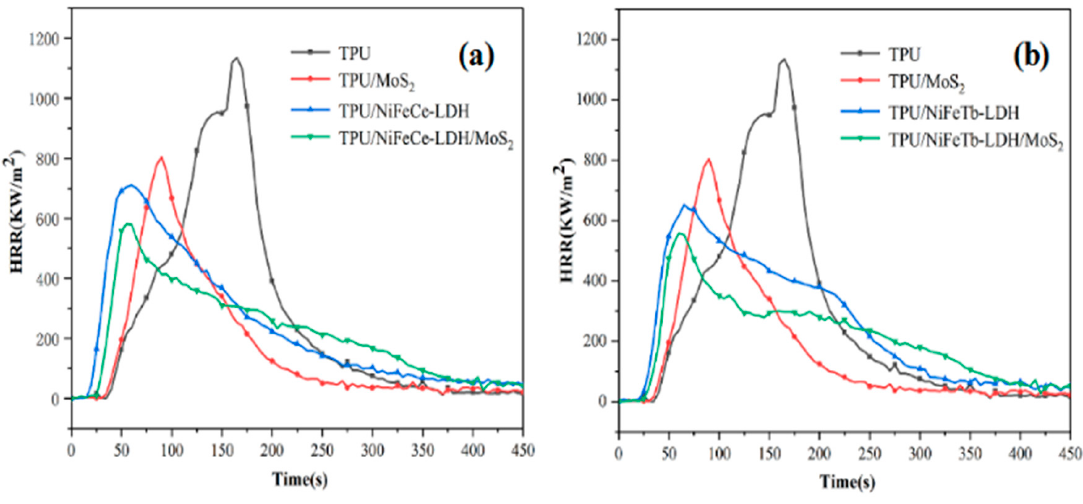
Figure 6. HRR curves of pure TPU and TPU composites ( a,b ).